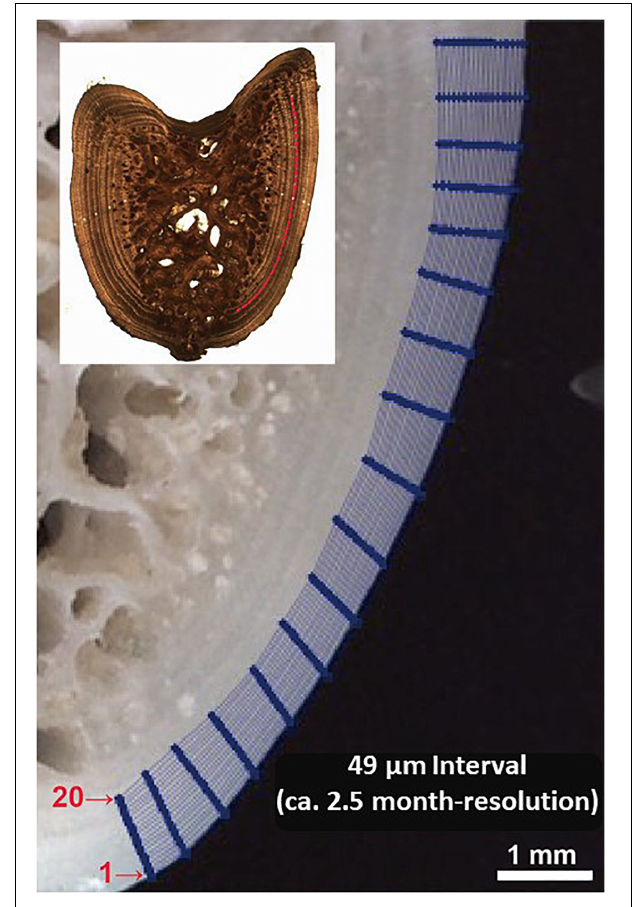
FIGURE 3 | Illustration of micromilling sampling plan designed for fin spine cross section. The sequence of analysis was done from the outer edge of the spine inwards ( i.e., lines 20 to 1) which follow the growth annual